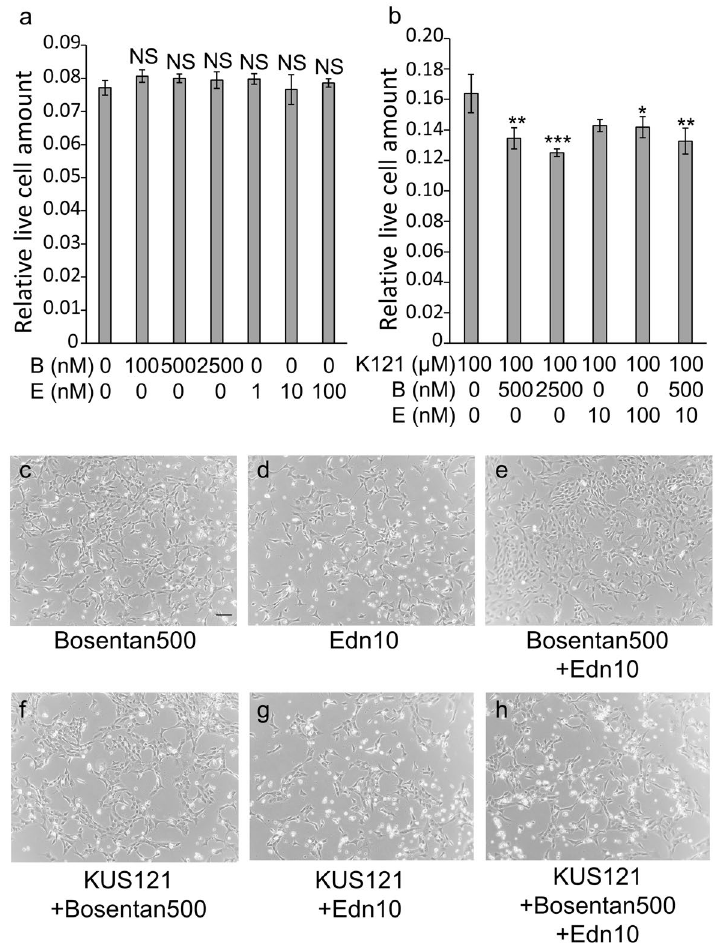
Figure 6. Cell viability of 661W cells cultured under glucose-free conditions with an endothelin antagonist or agonist. The amount of live cells was measured using WST-8 following 48 h treatment in glucose-free media with or without KUS121 (100 µM), with or without bosentan (100; 500; 2500 nM), and with or without endothelin-1 (1; 10; 100 nM). ( a , b ) Quantitative analysis of live cells ( n = 3, for all treatments). 661W cells were cultured under glucose-free conditions, with ( b ) or without KUS ( a ), with or without bosentan (100; 500; 2500 nM), and with or without endothelin-1 (1; 10; 100 nM). NS : no significant difference, vs. glucose-free without bosentan nor endothelin-1, Tukey’s HSD. * p < 0.05, ** p < 0.01, *** p < 0.001, vs. no glucose with KUS, Tukey’s HSD. K121: KUS121, B : bosentan, E : endothelin-1. ( c – h ) Representative images of 661W cells cultured under each condition. Bar: 50